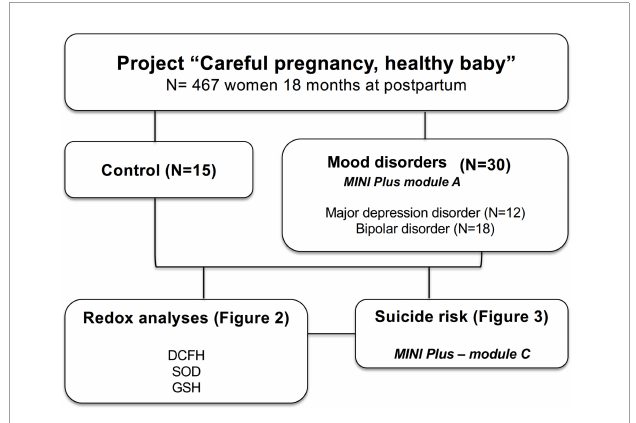
FIGURE1 Study organization chart. Women (control and mood disorder) were selected from the cohort entitled “Careful pregnancy, healthy baby” for analysis of plasma biomarkers of oxidative stress and risk of